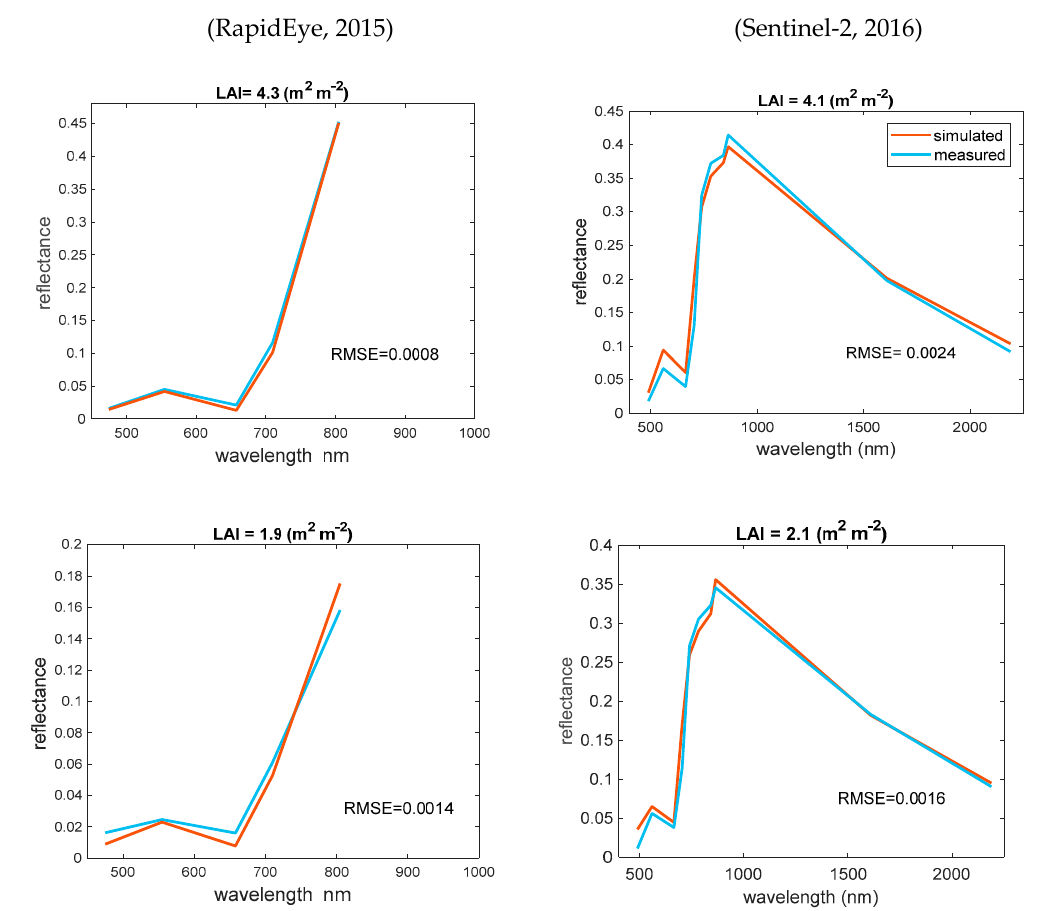
Figure 5. Measured and modelled canopy reflectance spectra of two sample plots with different LAI values using RapidEye (2015) and Sentinel-2 (2016) data. Reflectance values belong to distinct spectral bands; lines are used to help the interpretation.